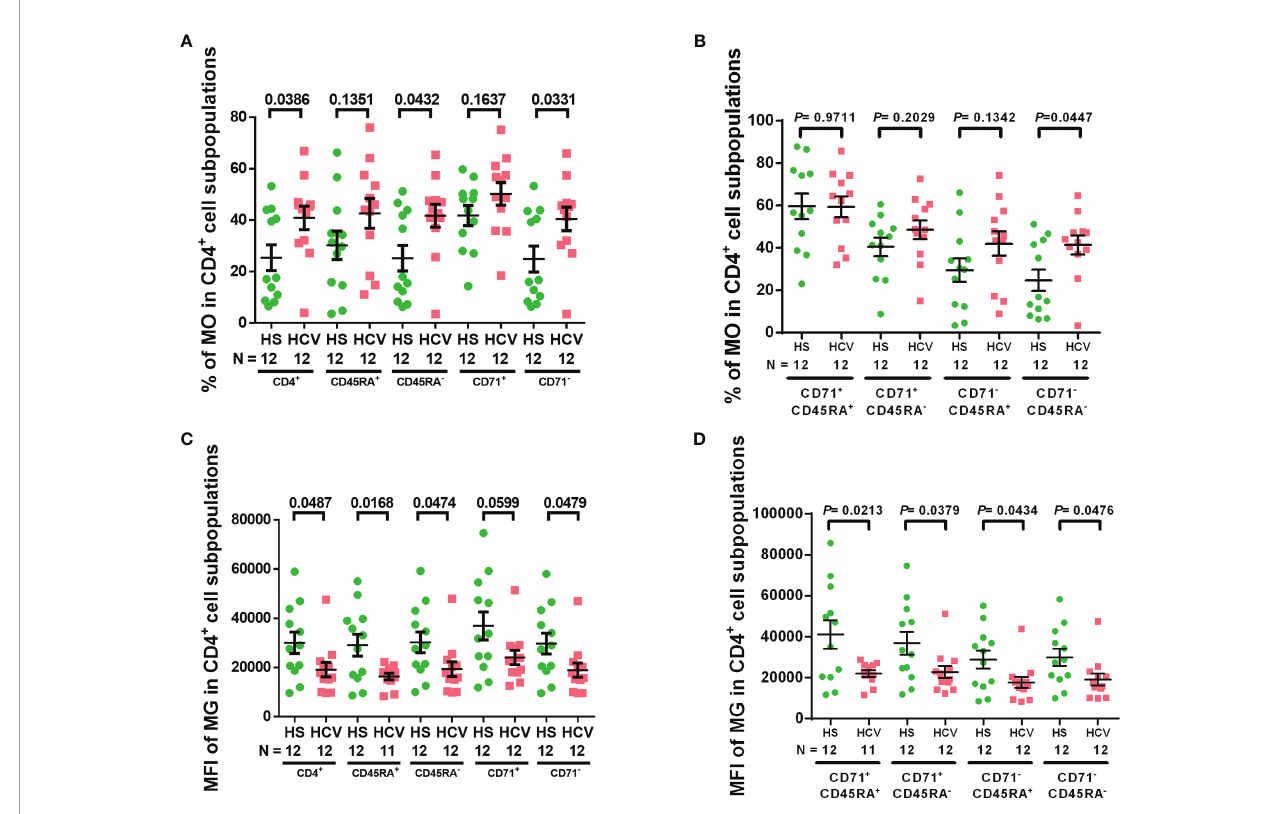
FIGURE 1 | CD4 T cell intracellular ROS and mitochondrial mass in HCV-infected individuals. (A, B) Frequency of MitoTracker Orange + (MO + ) cells in total CD4 + , CD4 + CD45RA + , CD4 + CD45RA - , CD4 + CD71 + , CD4 + CD71 - , CD4 + CD71 + CD45RA + , CD4 + CD71 + CD45RA - , CD4 + CD71 - CD45RA + , CD4 + CD71 - CD45RA - cell subpopulations from HCV-infected individuals and health subjects (HS). (C, D) MFI of MitoTracker Green (MG) in total CD4 + , CD4 + CD45RA + , CD4 + CD45RA - , CD4 + CD71 + , CD4 + CD71 - , CD4 + CD71 + CD45RA + , CD4 + CD71 + CD45RA - , CD4 + CD71 - CD45RA + , CD4 + CD71 - CD45RA - cell subpopulations from HCV-infected individuals and HS. The data were analyzed by parametric unpaired T-tests with or without Welch ’ s corrections or nonparametric Mann-Whitney U